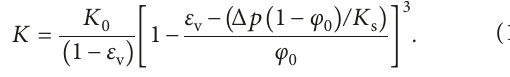
Figure 13: Calculation model of the stress intensity